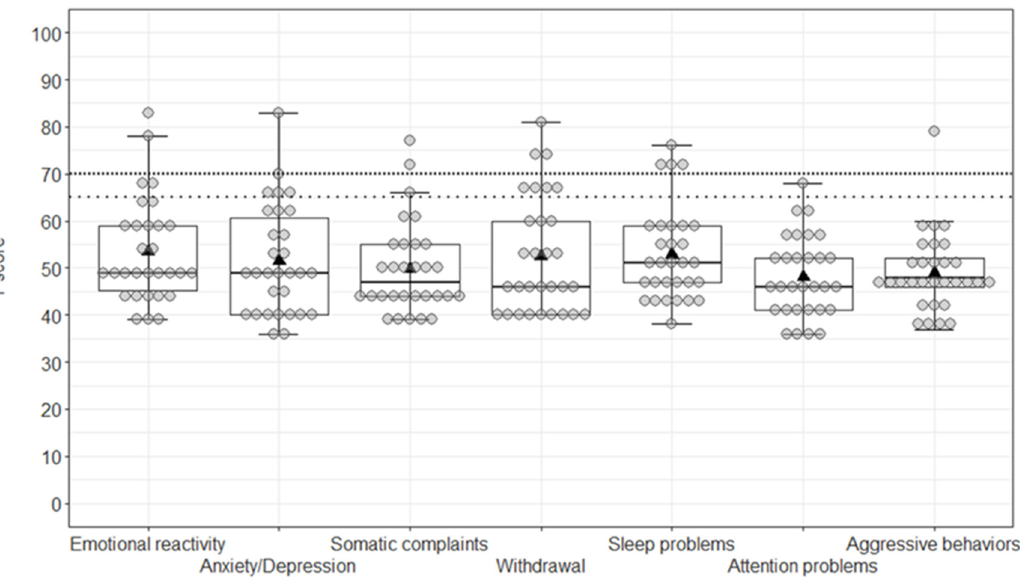
Figure 1. Boxplot of T-scores at the CBCL/1.5–5. Grey circles ( ● ) represent individual scores, black triangles ( ▲ ) indicate group mean scores; lines with wide and dense dots show, respectively, the borderline and clinical thresholds.